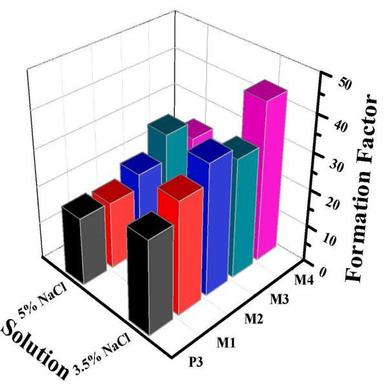
Formation factor.